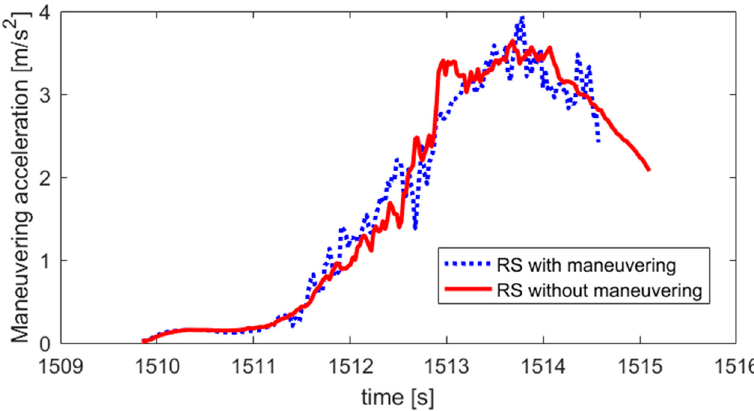
Figure 11. Maneuvering acceleration of NCSO.